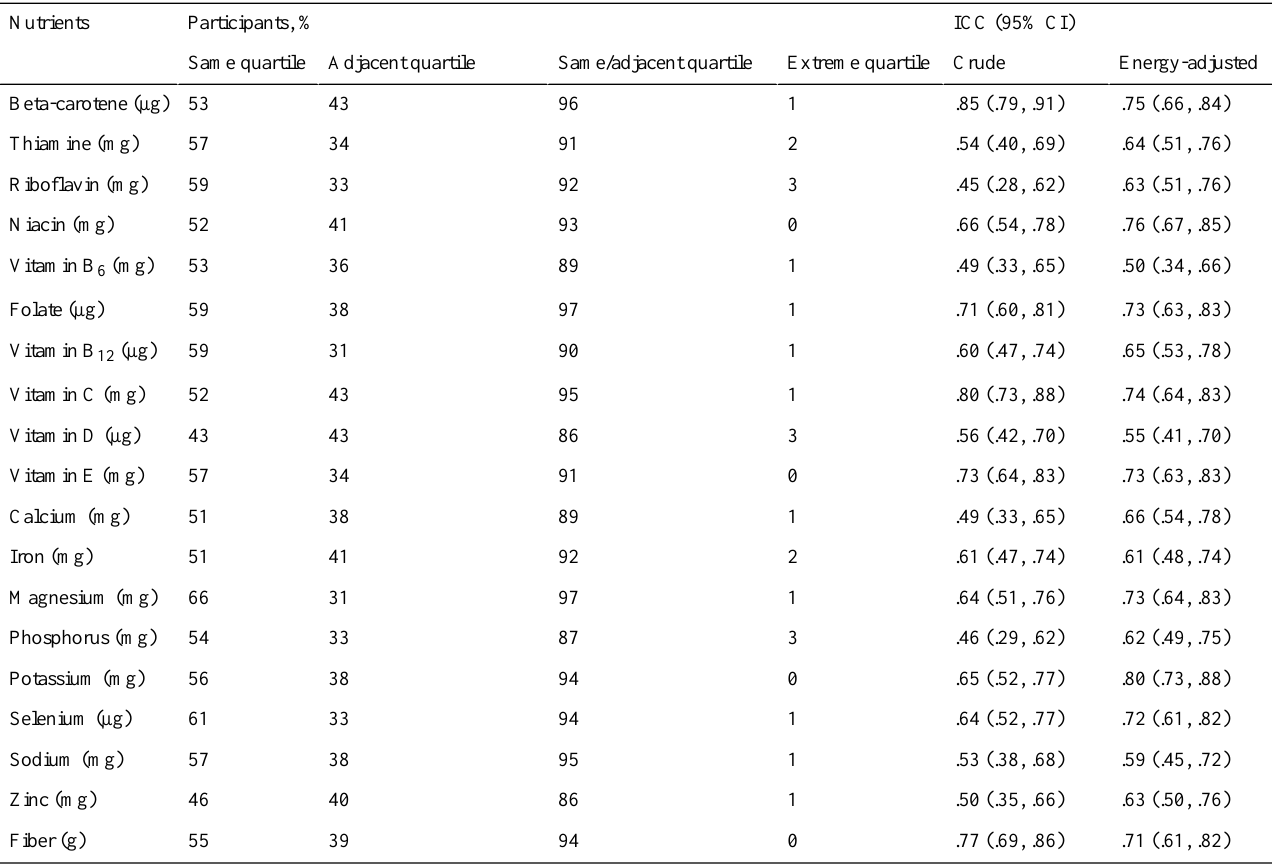
Table 7. Quartile cross-classifications of Meal-Q 1 and Meal-Q 2 a from group 2, and crude and energy-adjusted intraclass correlation coefficients (ICC)